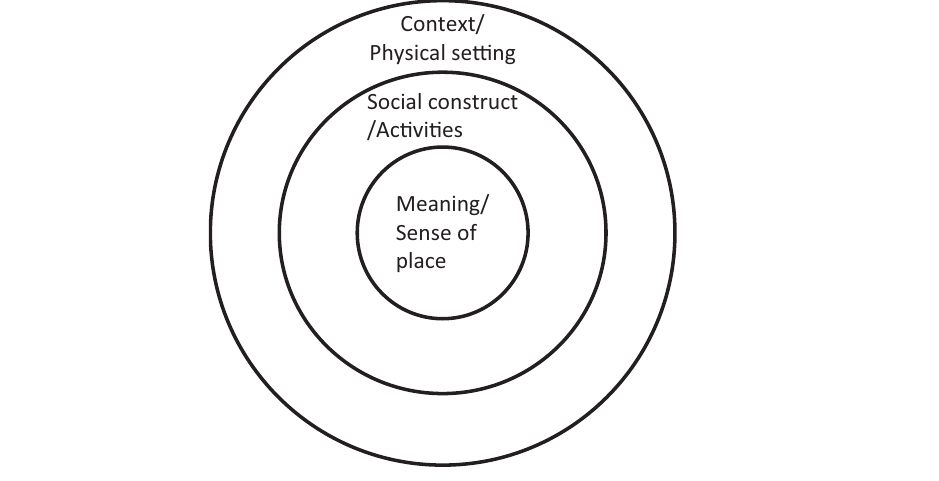
Figure 7. Proposed strong/nested model of placemaking. Source: